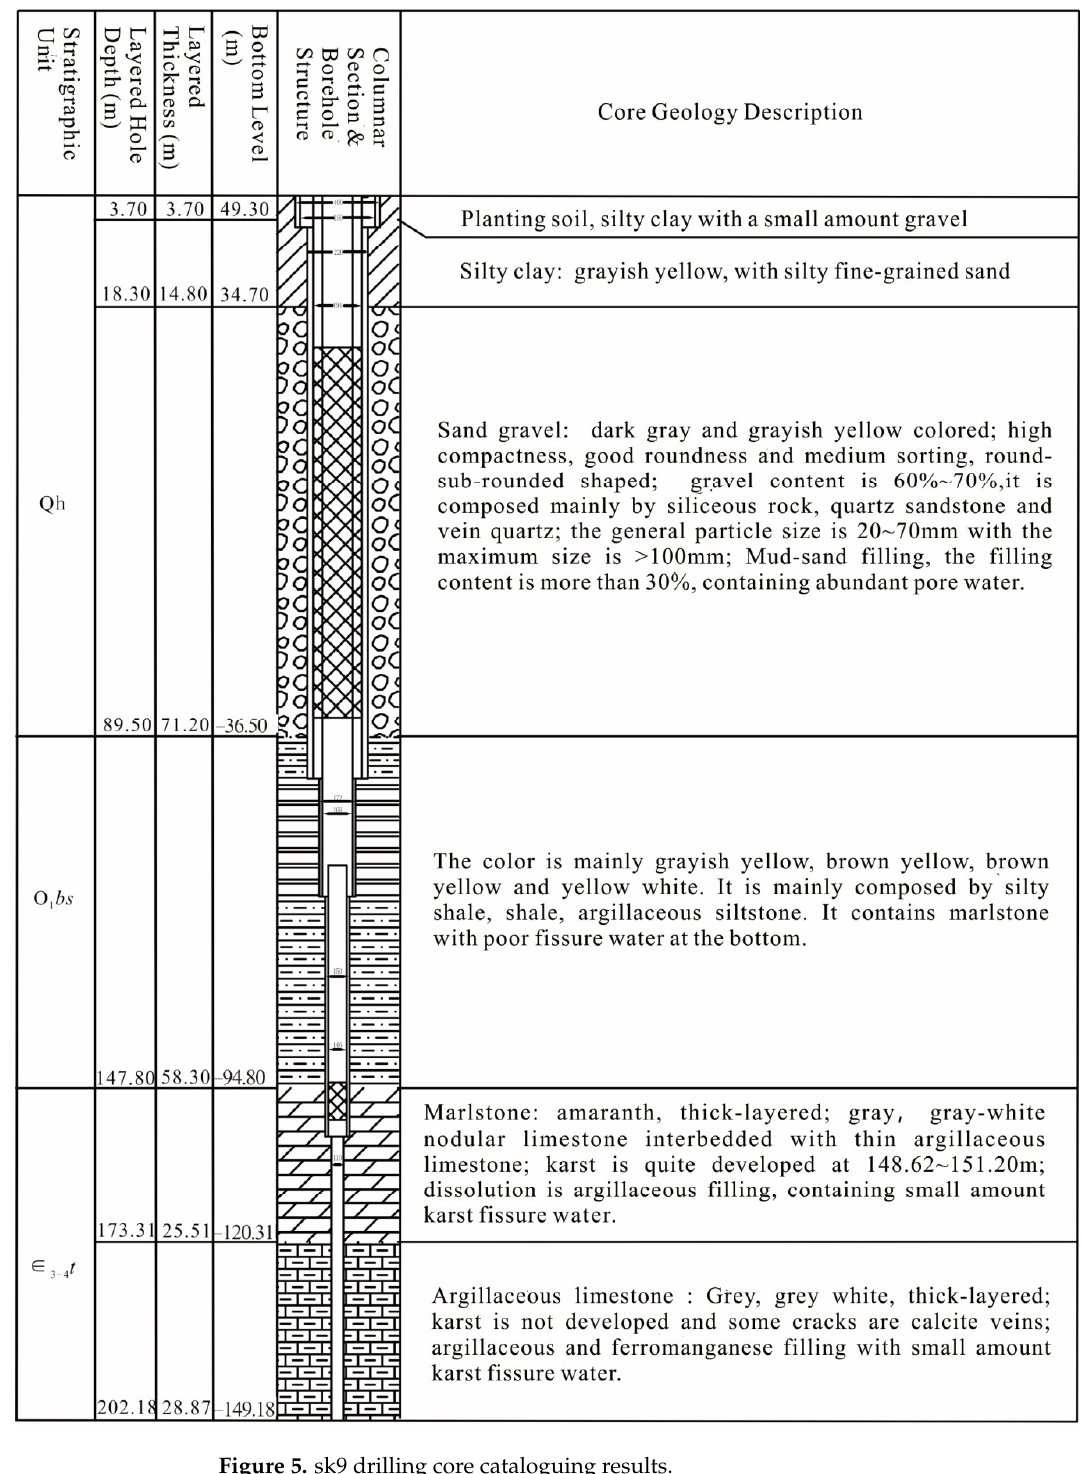
Figure 5. sk9 drilling core cataloguing results.